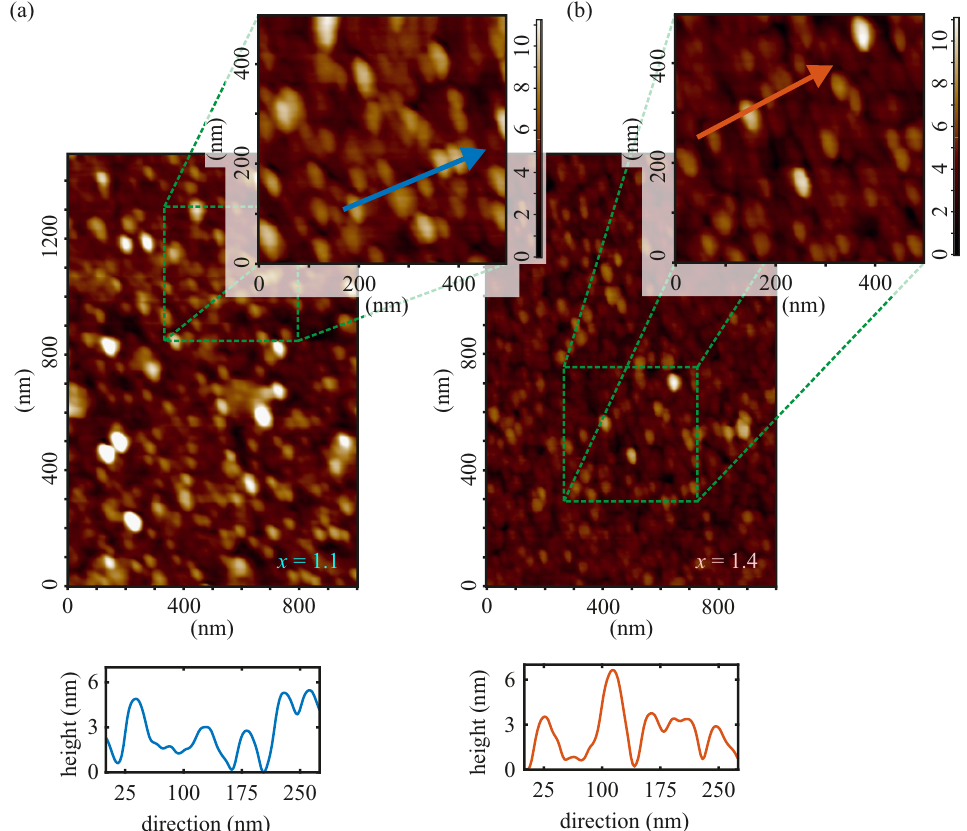
Figure 3. Representative AFM images and height profiles of the Co x Fe 3 − x O 4 films with ( a ) x = 1.1 and ( b ) x = 1.4. The blue and red arrows represent the directions of the respective height profiles presented